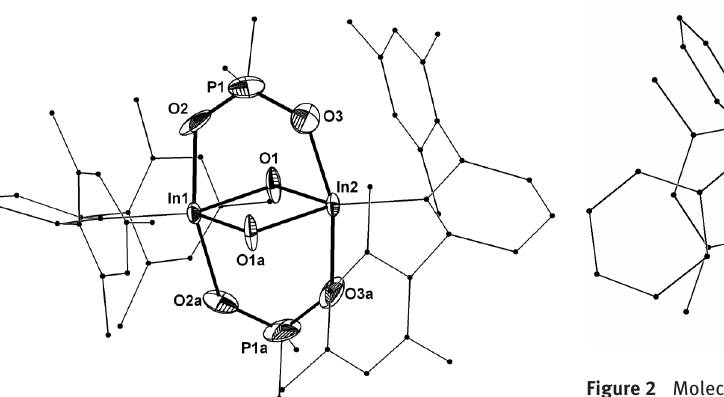
Figure 1 Molecular structure of 1 showing 30% probability ellip- soids and the crystallographic numbering scheme.